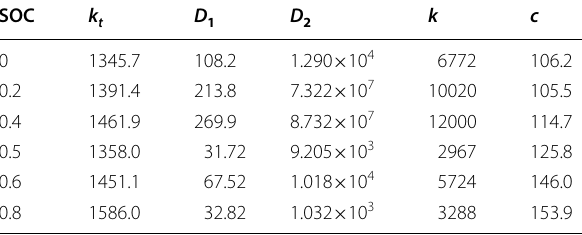
Table 5 Corresponding parameters of the modified equivalent mechanical model and cubic fitting equation under SOC 0, 0.2, 0.4, 0.5, 0.6, and =